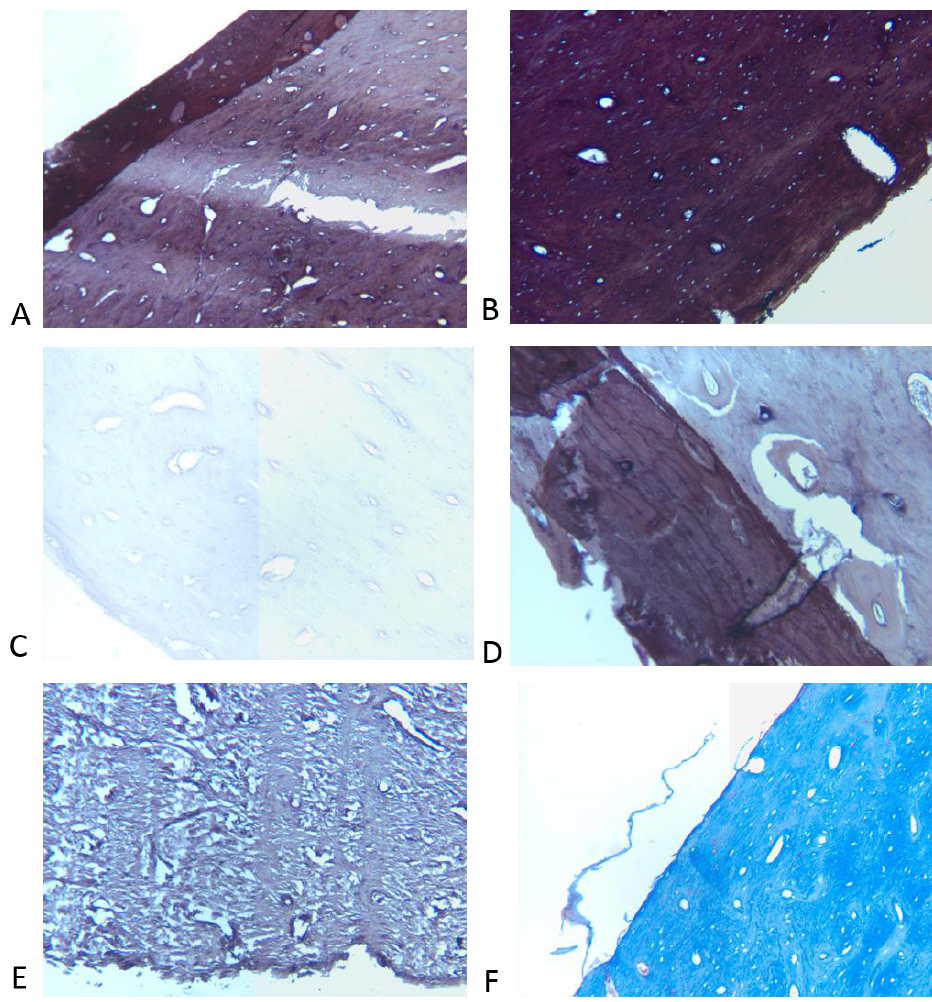
Fig. 5. Errors in processing result in flawed sections. A) Microtome banding from a damaged knife shown on the earbone due to specimen being too hard (photo original magnification 10x). B) Staining time was too long resulting in a specimen that is too dark (photo original magnification 10x). C) Poor fixation, poor decalcification and too brief a staining time result in an under-stained section (photo original magnification 40x). D) Edges of the earbone folded because the section is too thick (photo original magnification 10x). E) Torn sections can result from poor initial processing or poor sectioning technique or both (photo original magnification 40x). F) An alternate stain (trichrome stain) tried but the GLGs showed up poorly (photo original magnification